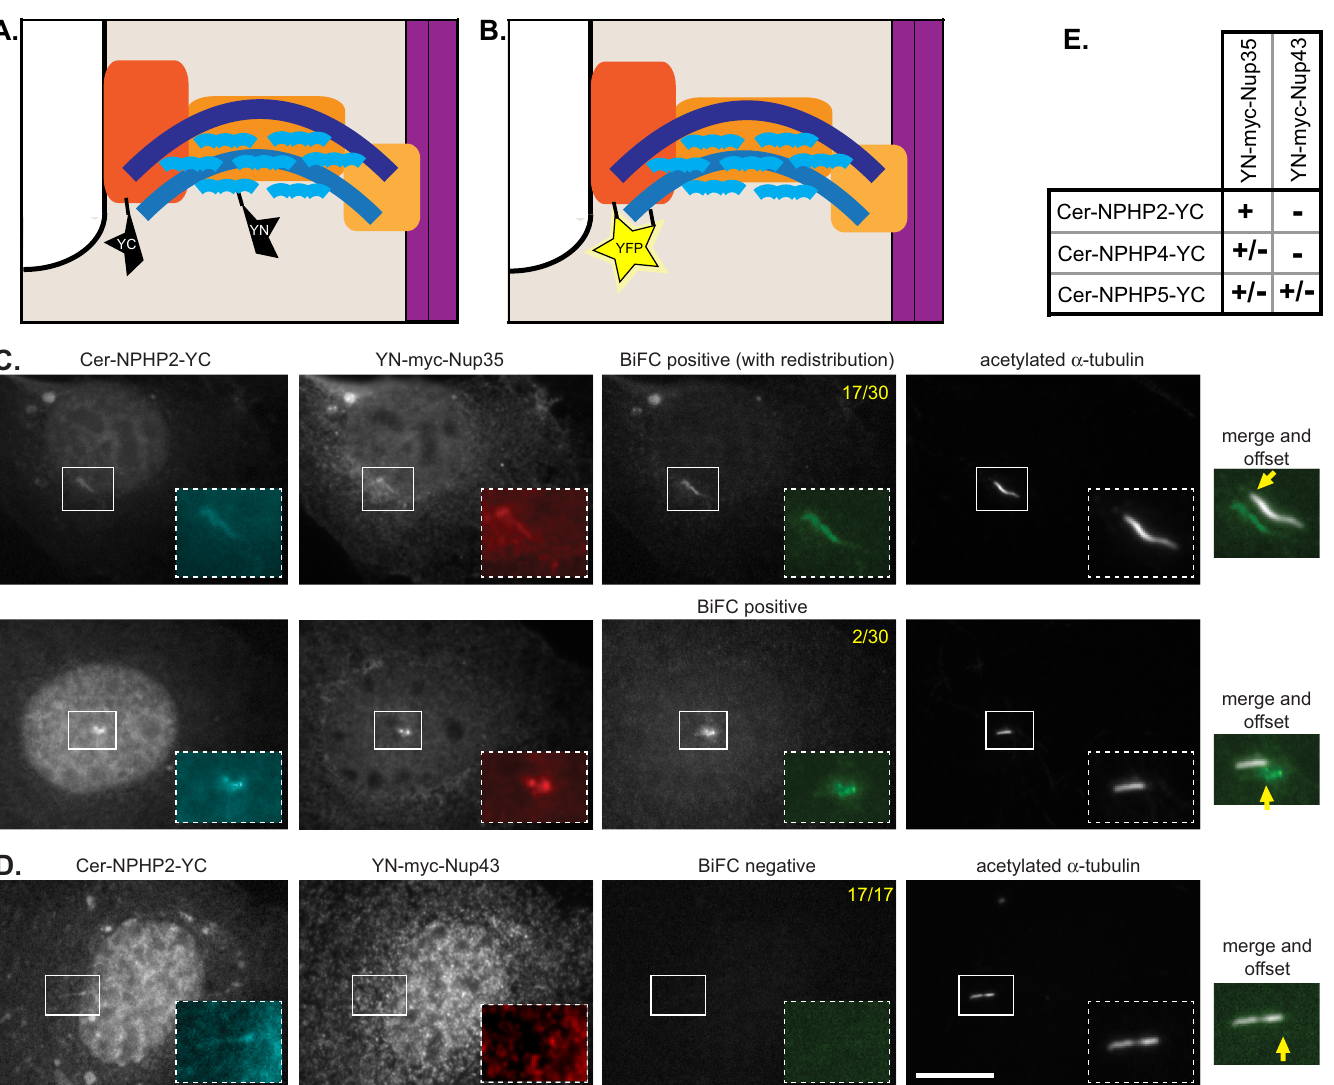
Fig 5. BiFC analysis reveals close association of NPHP2 and Nup35 at the base of the cilium. (A-B) Schematic of the assay. NPHP proteins (orange) were tagged with a C-terminal fragment of YFP (YC) and with Cerulean (Cer) to detect protein expression. Nucleoporin proteins (blue) were tagged with an N-terminal fragment of YFP (YN) and with a Myc-tag to detect protein expression. (A) When co-expressed in NIH 3T3 cells, the NPHP-YC and YN-NUP proteins localize to the base of the cilium but if they are not in close proximity, the YFP protein is not reconstituted (no BiFC). (B) If the NPHP-YC and YN-NUP proteins are in close proximity at the base of the cilium, then YFP is reconstituted and BiFC fluorescence is observed (right panel). (C) Co-expression of Cer-NPHP2-YC with the inner ring nucleoporin YN-myc- Nup35 results in a positive BiFC interaction. (D) Co-expression of Cer-NPHP2-YC with the outer ring nucleoporin YN-myc-Nup43 results in a positive BiFC interaction. Scale bar, 5 um. Yellow text in the top right corners indicate the number of cells displaying positive BiFC interactions across two independent experiments. Yellow arrows indicate the base of the primary cilium. (E) Summary of BiFC interactions observed for the indicated NPHP and nucleoporin proteins.